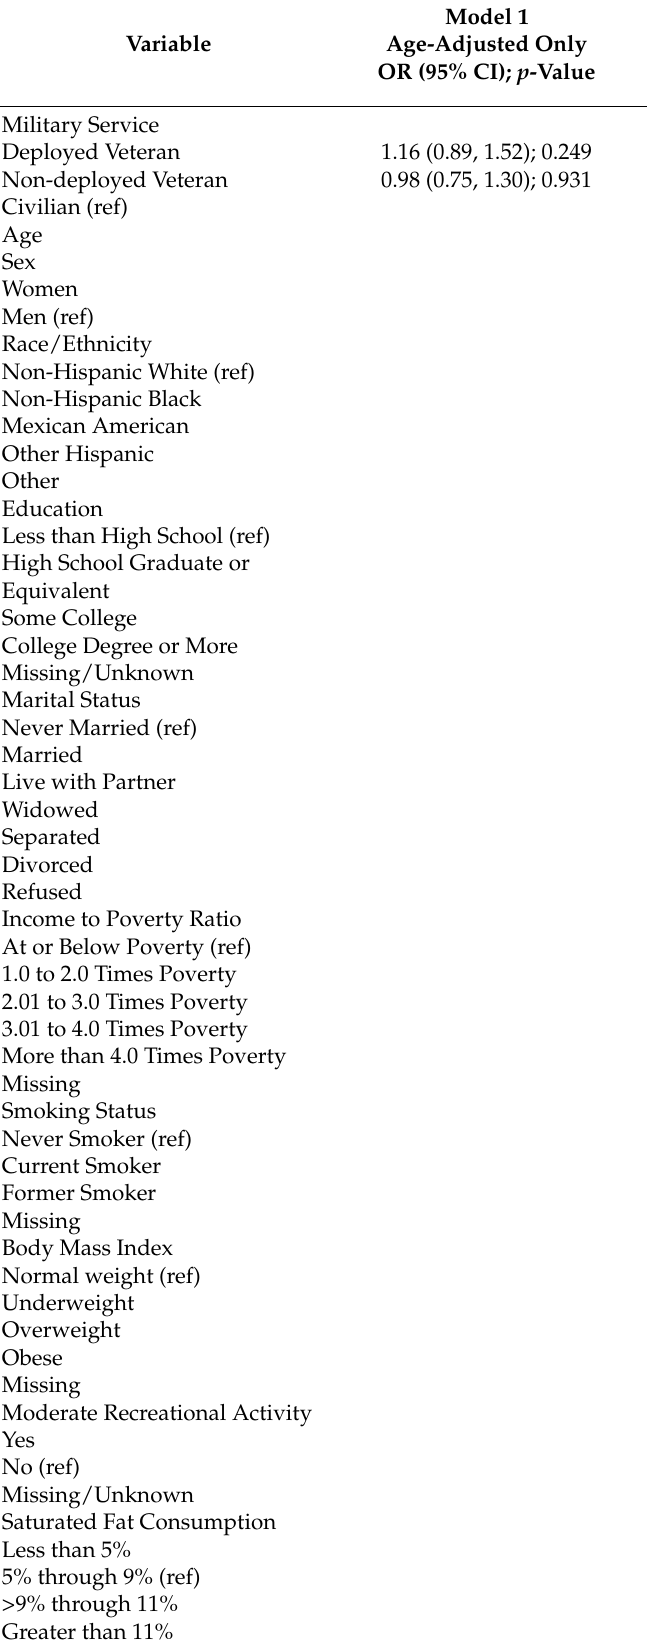
Table 3. Weighted results adjusted for age, demographic, socioeconomic status (SES), and health behaviors ( n = 11,285).